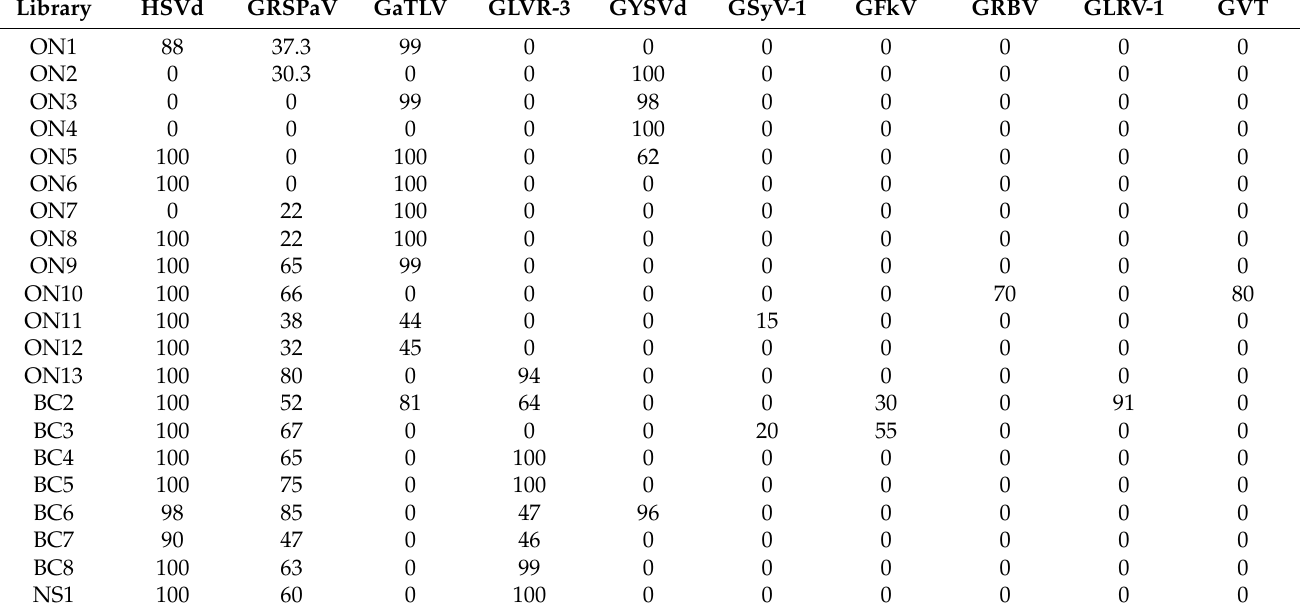
Table 4. Other viruses and viroid species detected in the 21 libraries surveyed using Virtool– PathoScope and their genome coverage, respectively. Acronyms: hop stunt viroid: HSVd; grapevine rupestris stem pitting associated virus: GRSPaV, grapevine associated tymo-like virus: GaTLV; grapevine leafroll-associated virus 3: GLRaV-3, grapevine yellow speckle viroid: GYSVd,